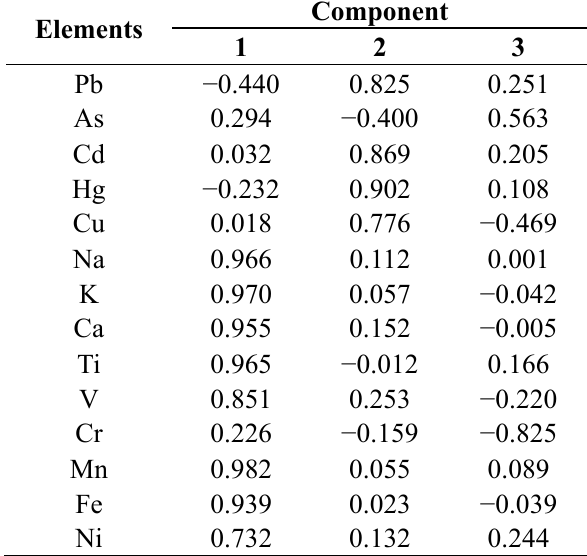
Table 6. The component matrix of PCA analysis for 14 elements in 18 batches of